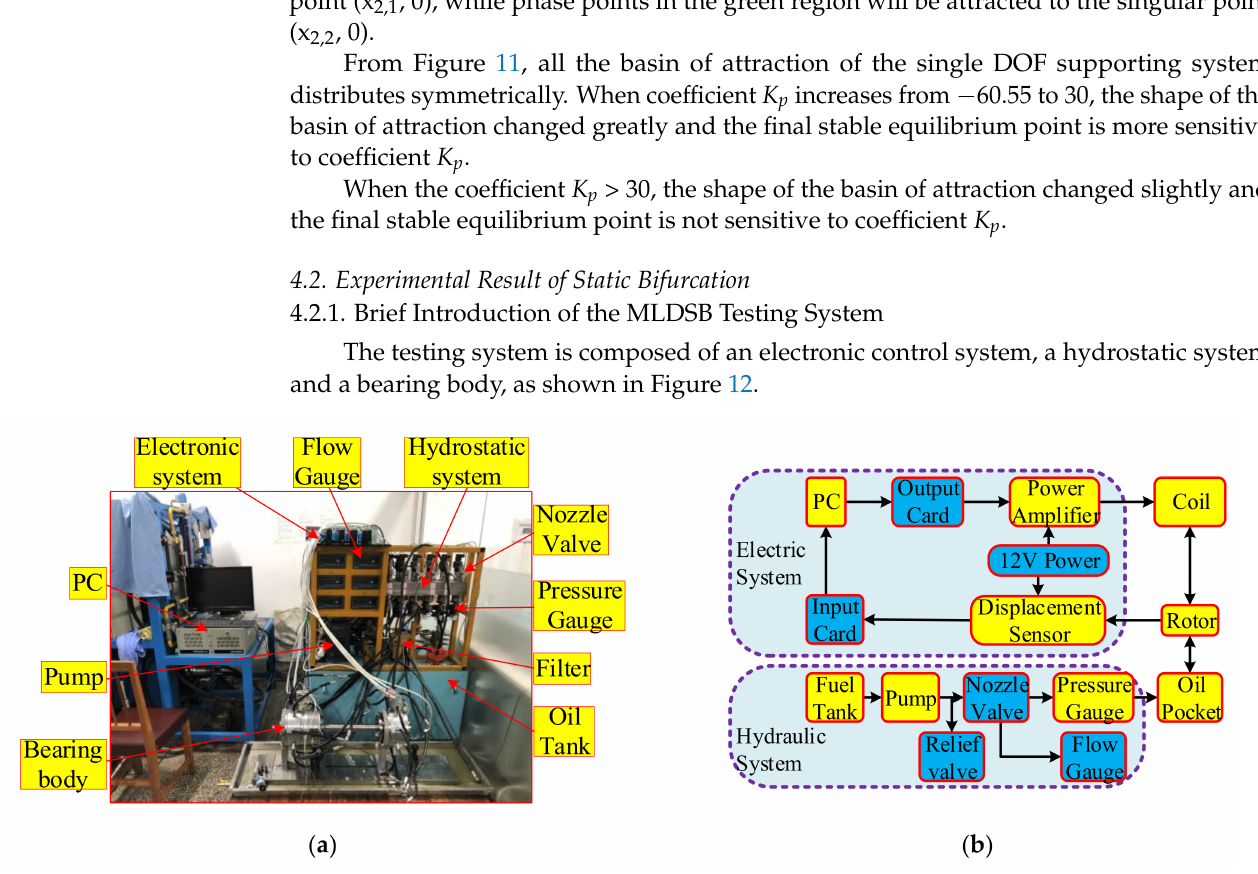
Figure 12. MLDSB Testing System. ( a ) Photo of MLDSB Testing System. ( b ) Connection diagram of MLDSB Testing System.